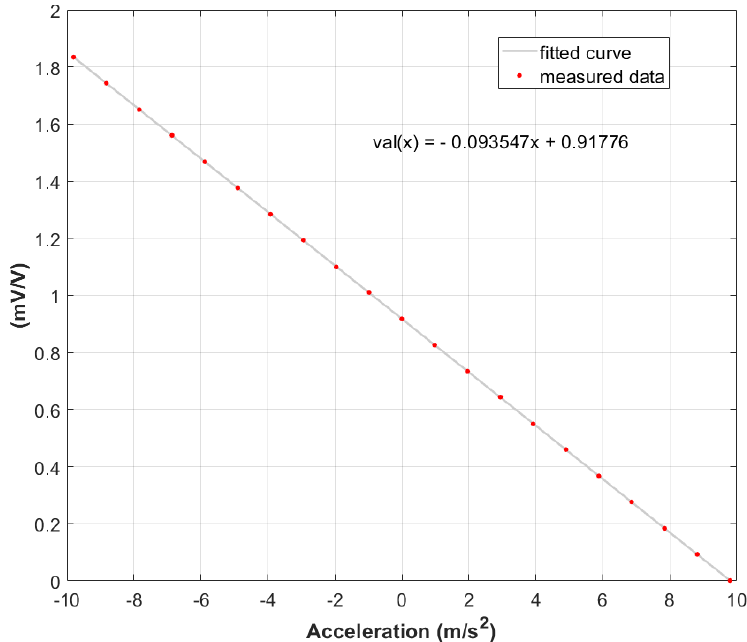
Figure A2. Calibration curve for the three-component accelerometer in the x